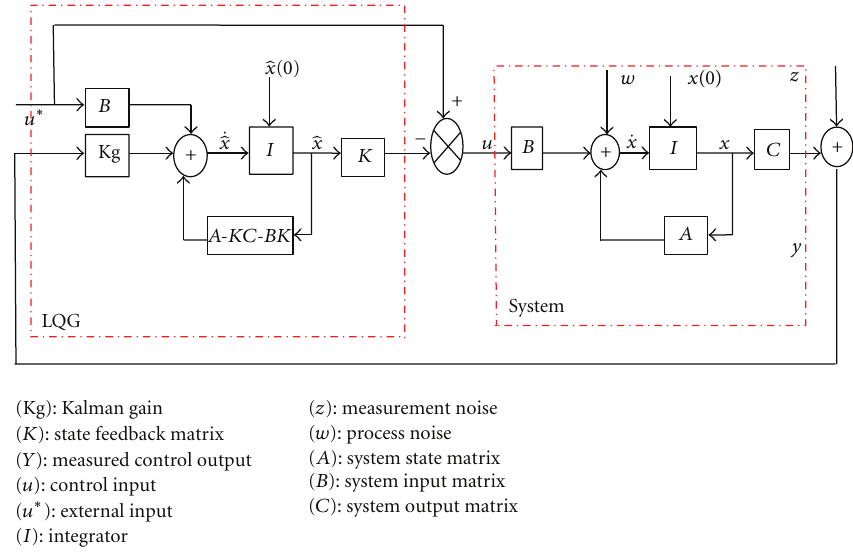
Figure 6: Configuration of the LQG system.